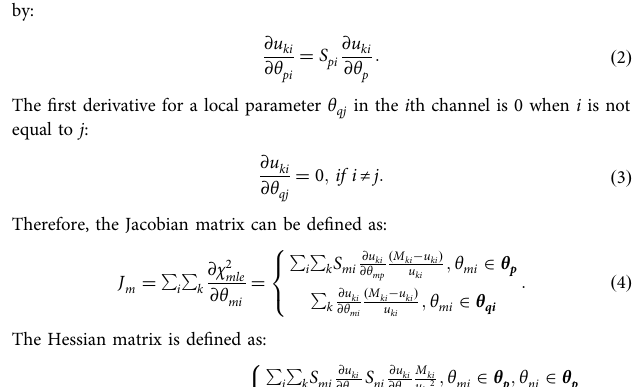
Fig. 6a). Three different methods were used to determine the color information: (1) The dual channel data was fi tted separately; (2) The dual channel data was fi tted globally with x, y and z as global parameters, photons and background as local parameters; (3) The dual channel data was fi tted globally with x, y, z and photons as global parameters, background photons as shared parameter. The ratio of the photons between different channels was fi xed during fi t. For the fi rst two methods, the color discrimination was realized by thresholding the normalized photon ratio: ð I (cid:2) I Þ = ð I þ I Þ . For the third method, the dual channel data was fi tted with 1 2 1 2 different fi xed and pre-determined photon ratios of all 4 dyes between the two channels and we then chose the solution with the maximum likelihood. For 4Pi single molecule data simulation (Supplementary Fig. 3), 2000 photons/ localization and 20 background photons/pixel were used for each objective. A full vectorial PSF model 37 was used for simulations with the following parameters: NA 1.35, refractive index 1.40 (immersion medium and sample) and 1.518 (cover glass), emission wavelength 668 nm, astigmatism 100 m λ . 1000 4Pi single molecule images with a ROI size of 15× 15 pixels were simulated at each z position with